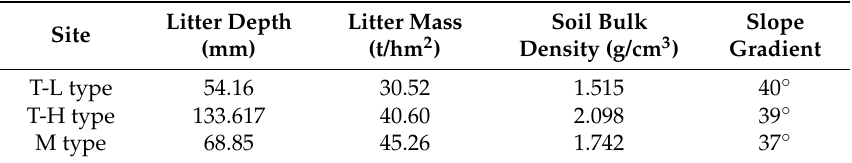
Table 1. Characteristics of liter layer and topsoil.